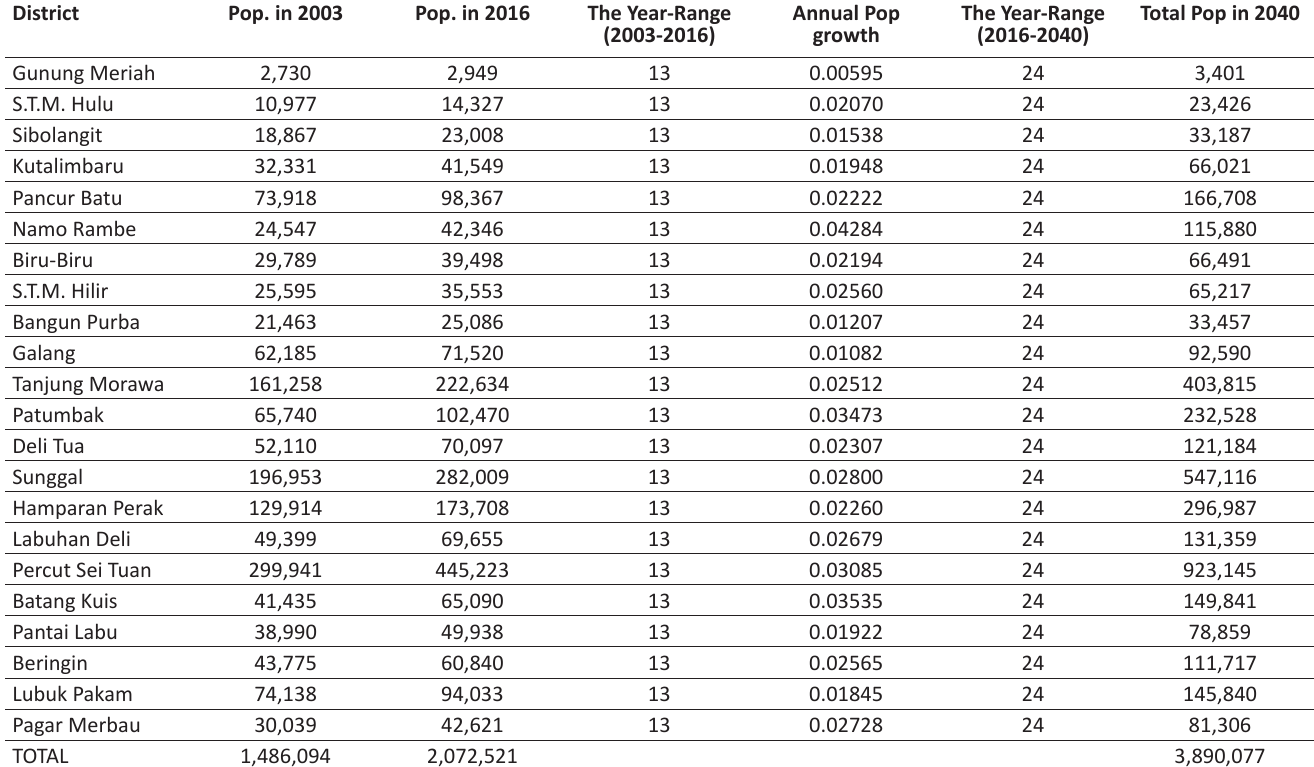
Table S1 . Population projection by 2040 in Deli Serdang Regency